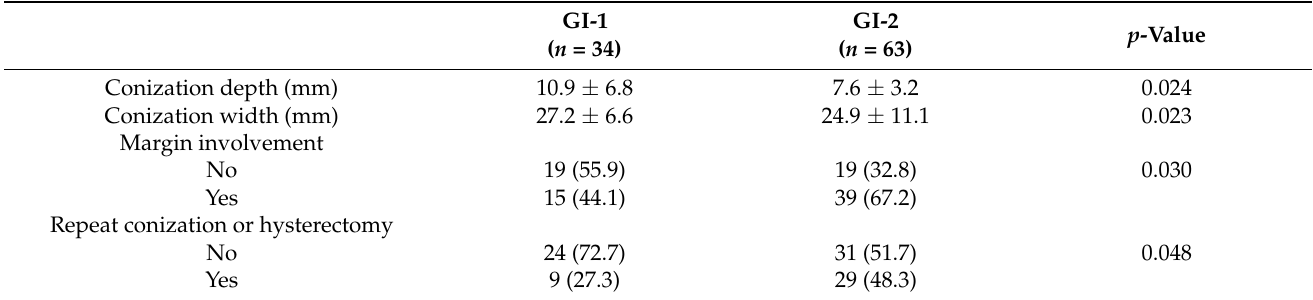
Table 3. Comparison of treatment outcomes between glandular involvement (GI)-1 and GI-2 among GI-positive patients ( n =